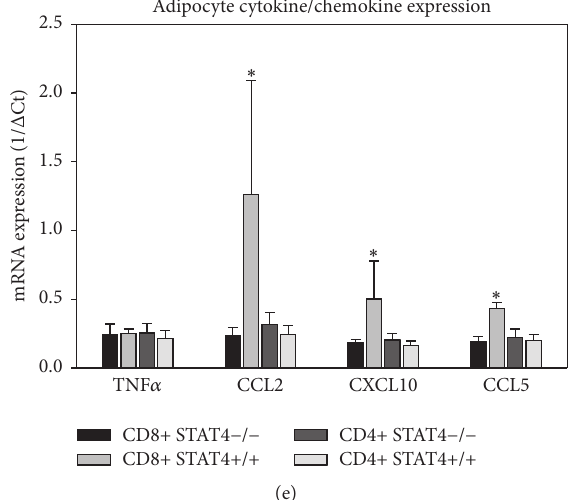
Figure 5: Immune composition and inflammation in epididymal adipose tissue of Rag1 − / − mice following adoptive transfer and HFD. (a) FlowcytometryanalysisofleukocyteandCD4+Tcellsinadiposetissuestromalvascularfraction(SVF)andspleenofRag1 − / − micefollowing adoptive transfer with STAT4+/+ CD4+ or with STAT4 − / − CD4+ cells. The number of cells was counted in the CD45+ gate and the double immunopositive CD3+CD4+ population was measured within the CD45+ gate. (b) Representative FACS plots illustrating the general gating strategy. (c) Same flow cytometry protocol was applied to determine the total number of leukocytes and Cd3+CD8+ positive cells in SVF and spleens of Rag1 − / − mice adoptively transferred with STAT4+/+ CD8+ or with STAT4 − / − CD8+ cells. Histograms in (a) and (c) represent mean ± SEM from 5–7 mice/group. (d) Real-time PCR chemokine gene expression in pancreatic islets of STAT4+/+ CD8+ and STAT4 − / − CD8+ mice after 15 weeks of HFD ( 𝑛 = 6 /group). (e) Real-time PCR gene expression of cytokines and chemokines of adipocytes isolated from epididymal adipose tissue of adoptively transferred mice following 15 weeks of HFD ( 𝑛 = 6 mice/group); ∗ 𝑝 < 0.05